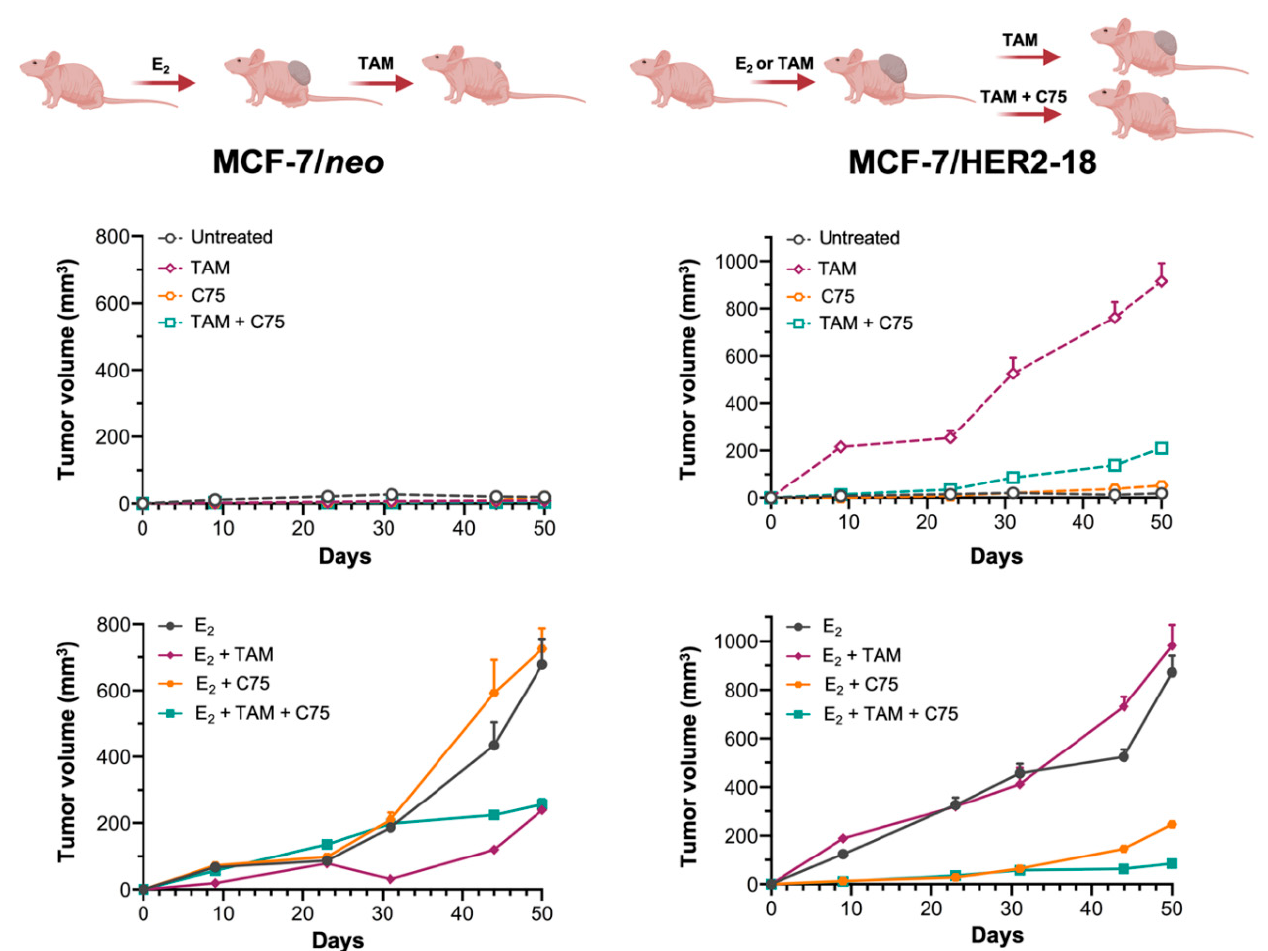
Figure 4. FASN inhibition suppresses tamoxifen-stimulated growth of MCF-7/HER2-18 tumors. Growth of MCF-7 and MCF-7/HER2-18 xenograft tumors in athymic female mice treated with C75 in the absence or presence of estrogen (E 2 ) or tamoxifen. The maximum length for each treatment was 50 days. Results are presented as the mean tumor volume ± S.D. ( n = 10 mice/experimental group).